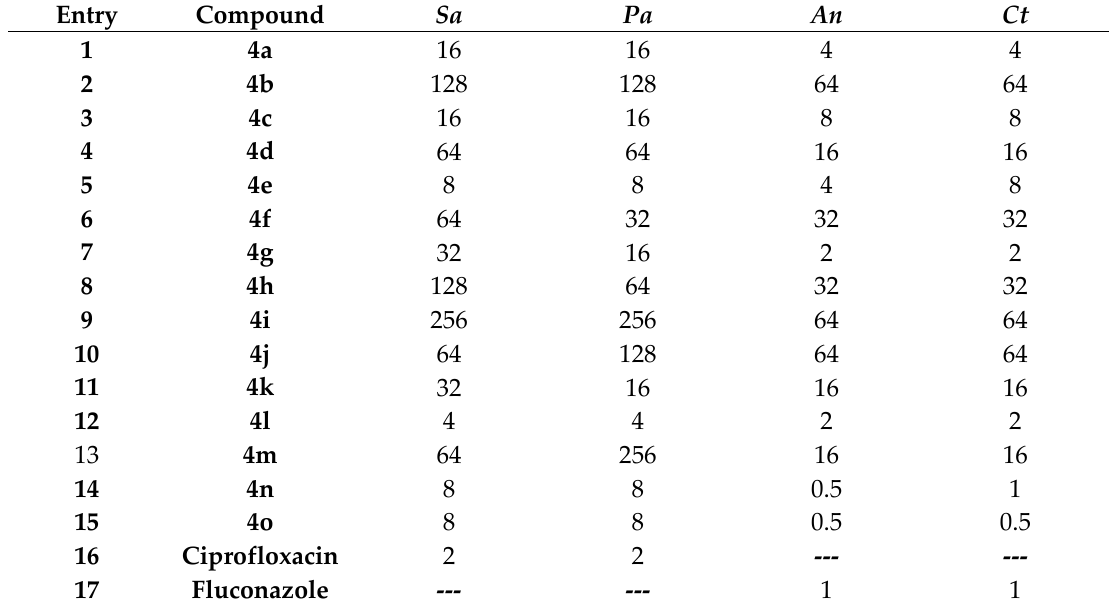
Table 2. Results of the antibacterial and antifungal activity of pyrazolines